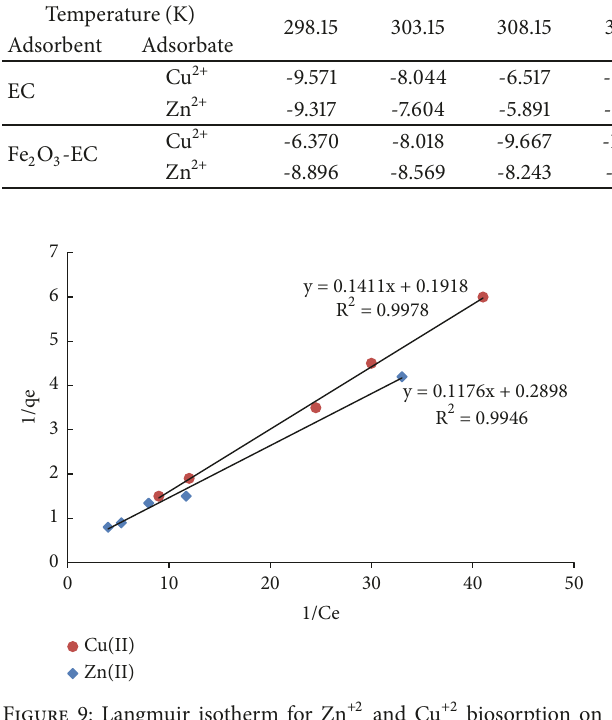
Figure 9: Langmuir isotherm for Zn +2 and Cu +2 biosorption on Fe 2 O 3